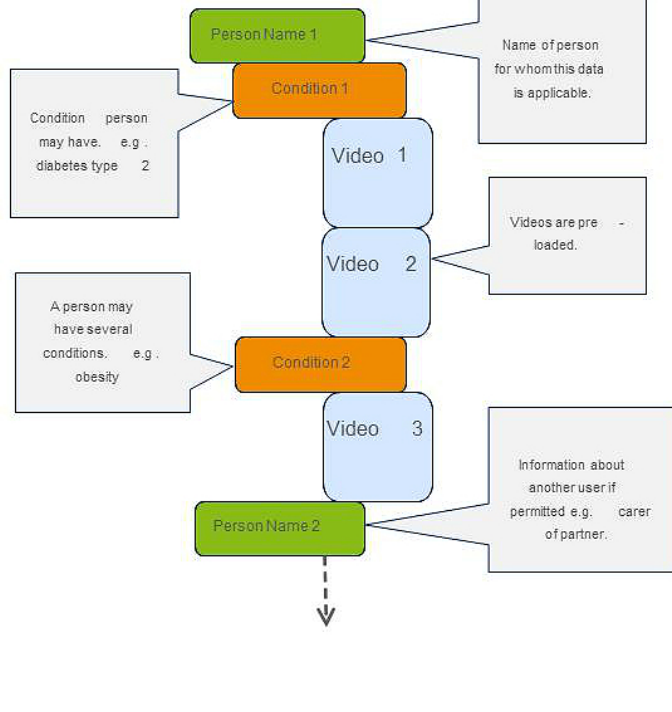
Figure 2. Dynamic user-specific data passed from SeeCare to Ericsson